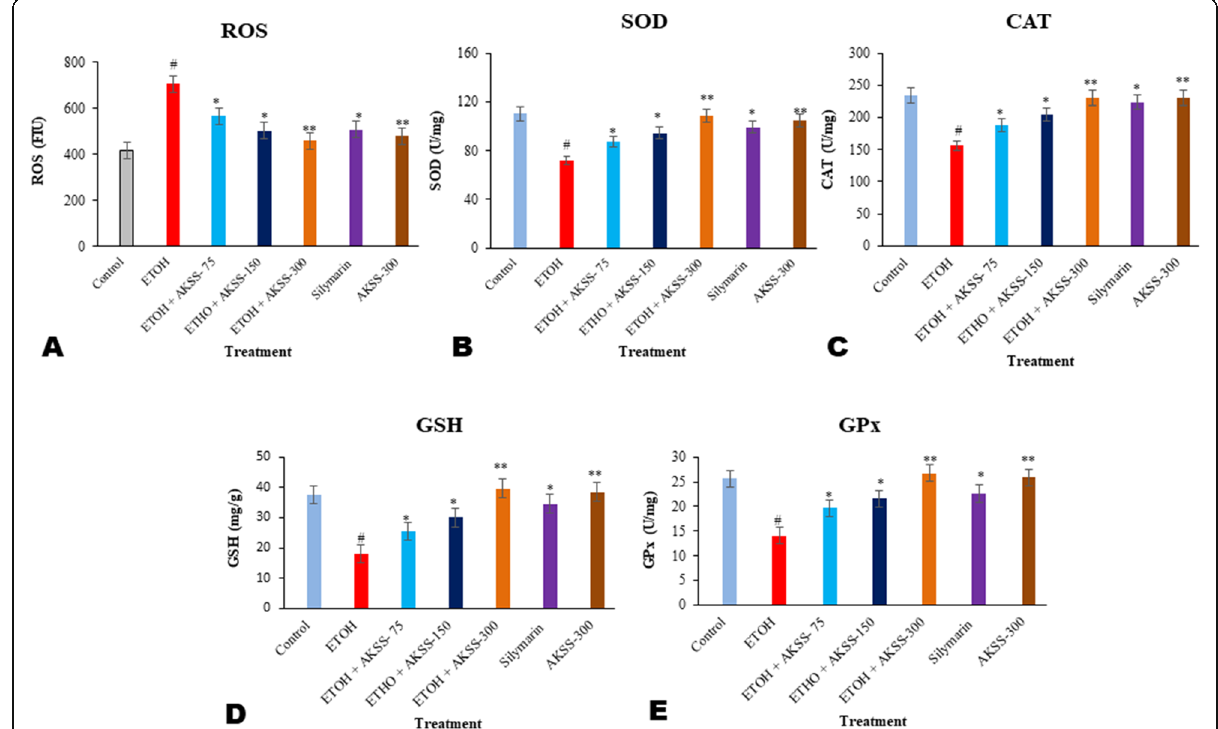
Fig. 4 Determination of the total reactive oxygen species (ROS) contents and levels of various antioxidant enzymes. The values are expressed as the mean ± SEM. Significantly difference # P < 0.001 compared to the untreated control group and * P < 0.001, ** P < 0.001 significantly difference compared to the ethanol treated group. Group-I: Control; Group-II: Ethanol treated; Group-III: ASKK-75 mg/kg; Group-IV: AKSS-150 mg/kg; Group-V: AKSS-300 mg/kg; Group-VI: Silymarin – 100 mg/kg; Group-VII: